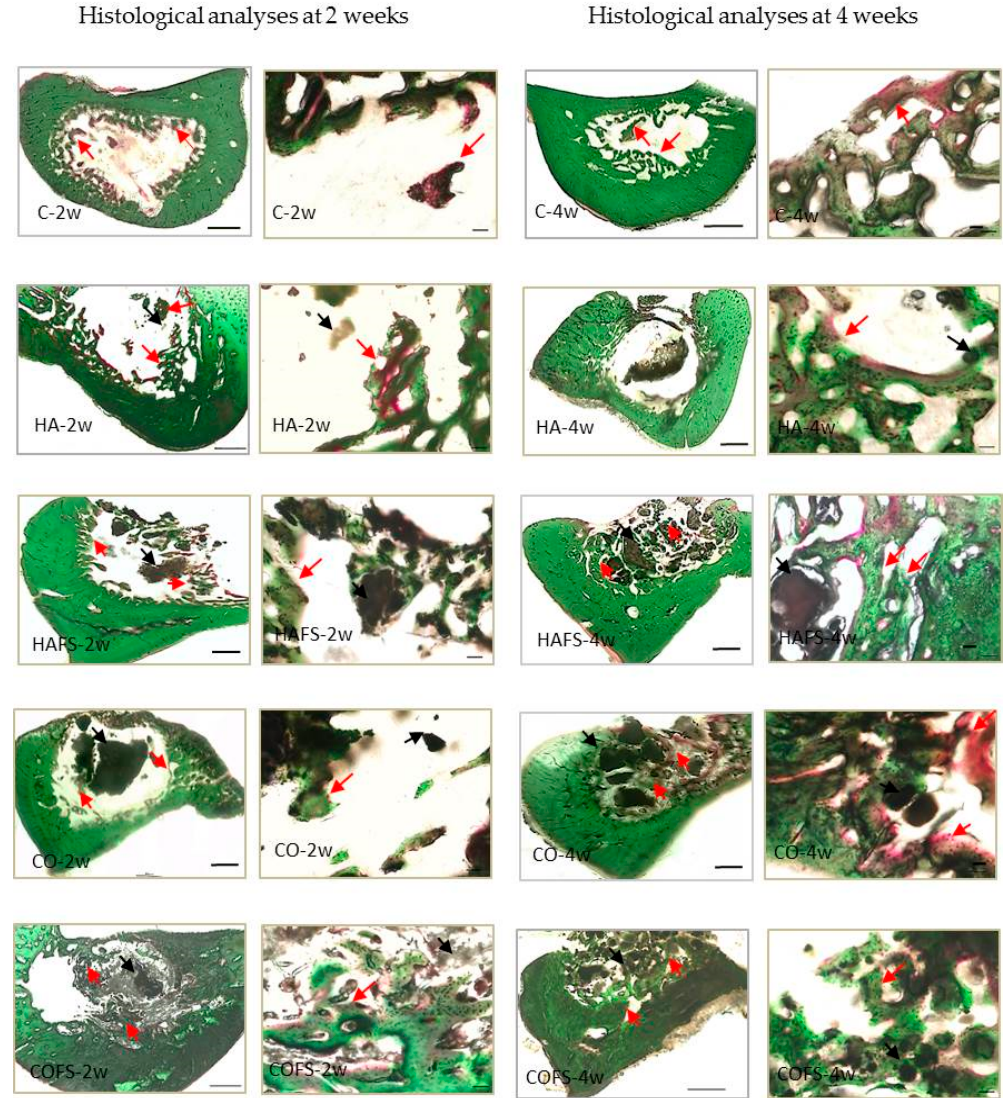
Figure 7. Histological images of lower right incisor extraction sockets at two and four weeks. Red arrows indicate new bone formation and black arrows indicate residual bone substitute in the healing socket. Magnification: ×4 Bar: 500 μ m, ×20 Bar: 50 μ m.